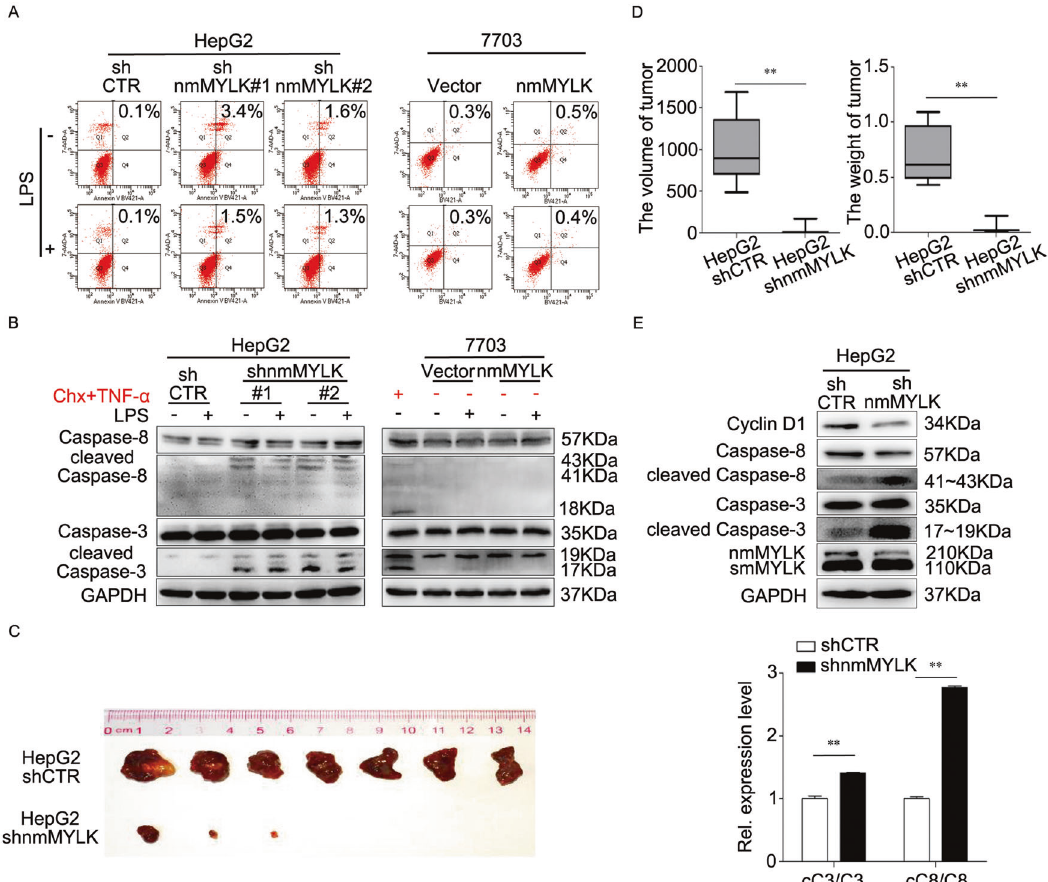
Fig. 3 Downregulation of nmMYLK in HCC cells promotes tumor cells apoptosis and attenuates tumor formation in nude mice. A, B HepG2 cells were transfected with shRNA-nmMYLK lentivirus or lentivirus-vector control before LPS treatment, 7703 cells were transfected with nmMYLK expression constructs or its vector before LPS treatment. Flow cytometry ( A ) and western blot ( B ) were used for examining the apoptosis rate of HepG2 and 7703 cells. C, D Mice xenograft models were constructed by inoculated HepG2 cells subcutaneously. Tumors dissected from different groups ( C ), tumor volumes and weight analysis ( D ). E Relative cascade reactions of caspases in xenograft tumors were examined using western blot. Data were performed by mean with SD from three independent experiments. ** P <